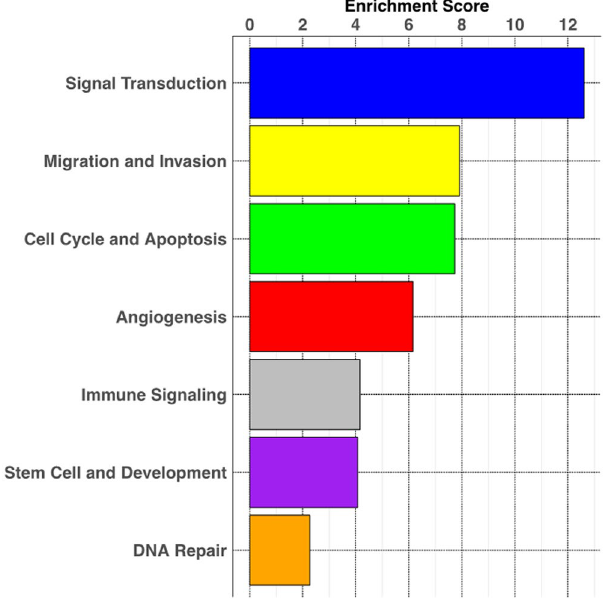
Figure 6. Pathway enrichment analysis. The DEG data for the 125 glioma-associated gene set for all the species was inputted into the DAVID function annotation algorithm. The enriched DEG sets were categorized into seven enriched pathway groups, and enrichment score was calculated for each pathway